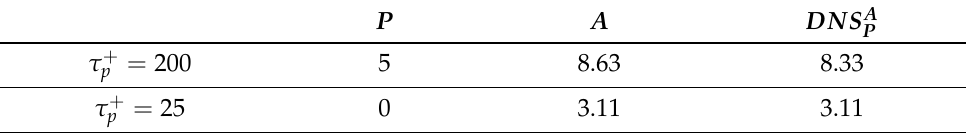
Table 2. Relative error of prediction of peak values and positions of rms + u (in percentage). Nomen- clature: P , Position; A , Amplitude; DNS A , DNS Peak Amplitude. P